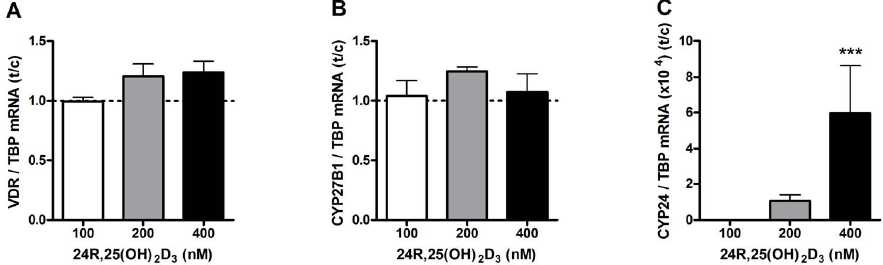
Figure 8. Effects of 24R,25(OH) 2 D 3 on VDR, CYP27B1 and CYP24 mRNA levels in primary human osteoblasts. Osteoblasts were cultured in the presence of 0, 100, 200 or 400 nM 24R,25(OH) 2 D 3 and mRNA levels of VDR ( A ), CYP27B1 ( B ) and CYP24 ( C ) were determined after 72 hours. Results (mean 6 SEM) are expressed as treatment versus control ratios (control was set at 1.0; dashed line) using cells from 4 different donors. Results were analysed using Friedman test followed by Dunn’s post hoc test (*p , 0.05, **p , 0.01, ***p ,